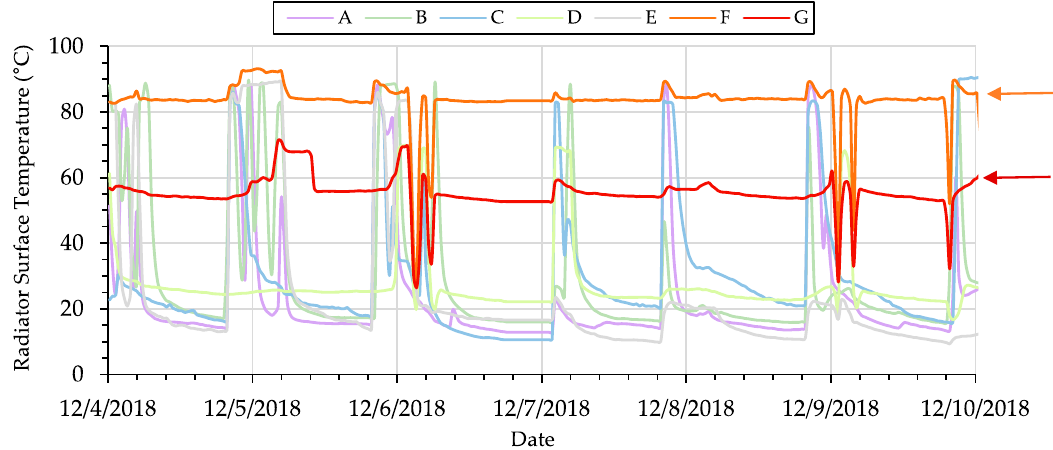
Figure 11. One week of radiator surface temperature data revealed a fault in the system (red arrows). Lines labeled A through G indicate individual radiators, each in separate rooms in the building.